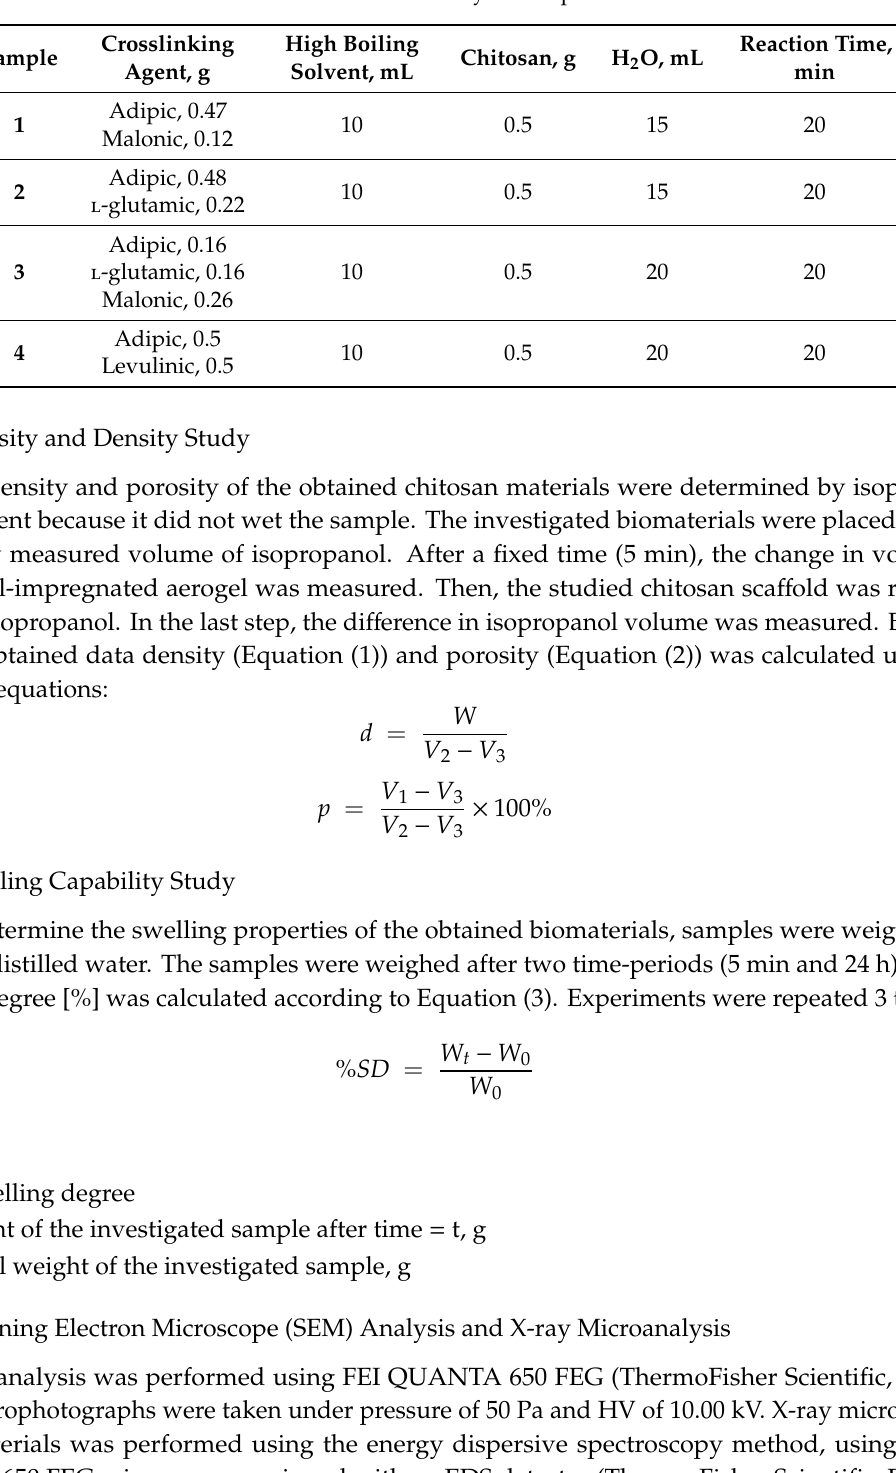
Table 1. Chitosan sca ff olds synthesis